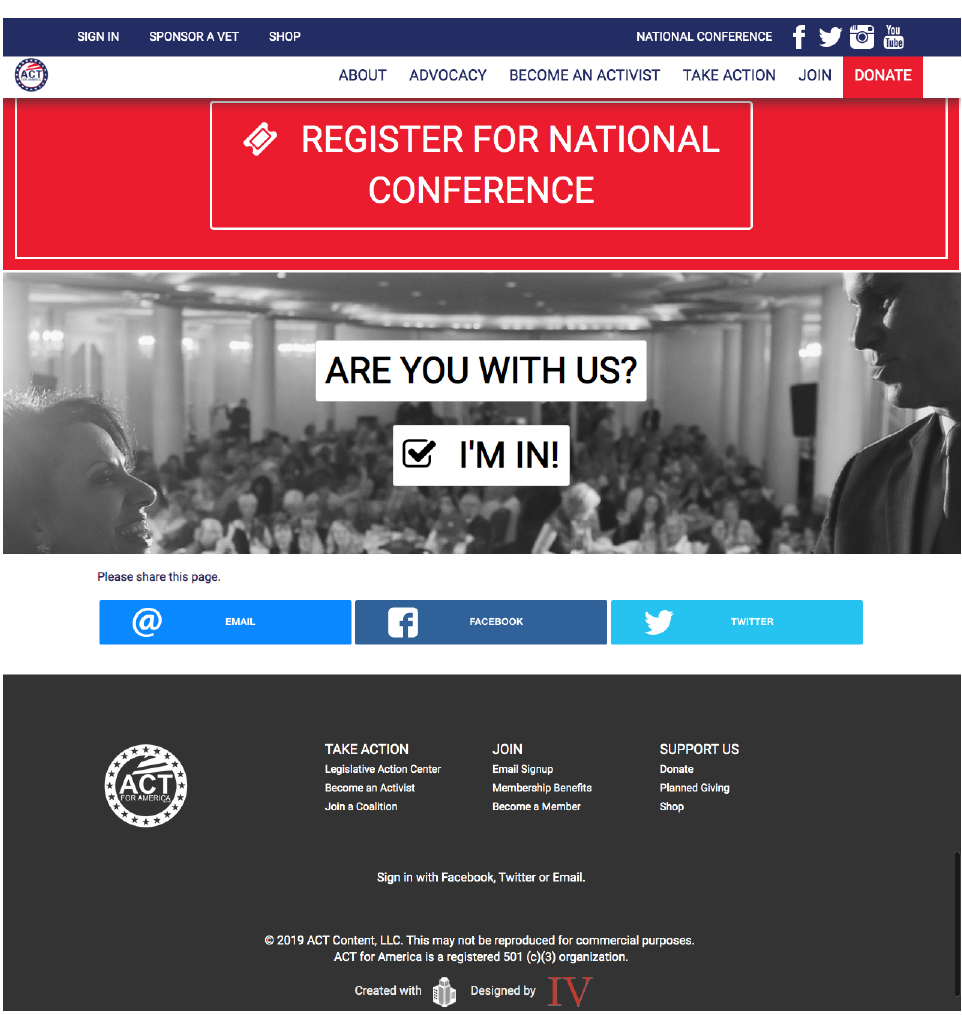
Figure 5: Act for American website, captured 23 April